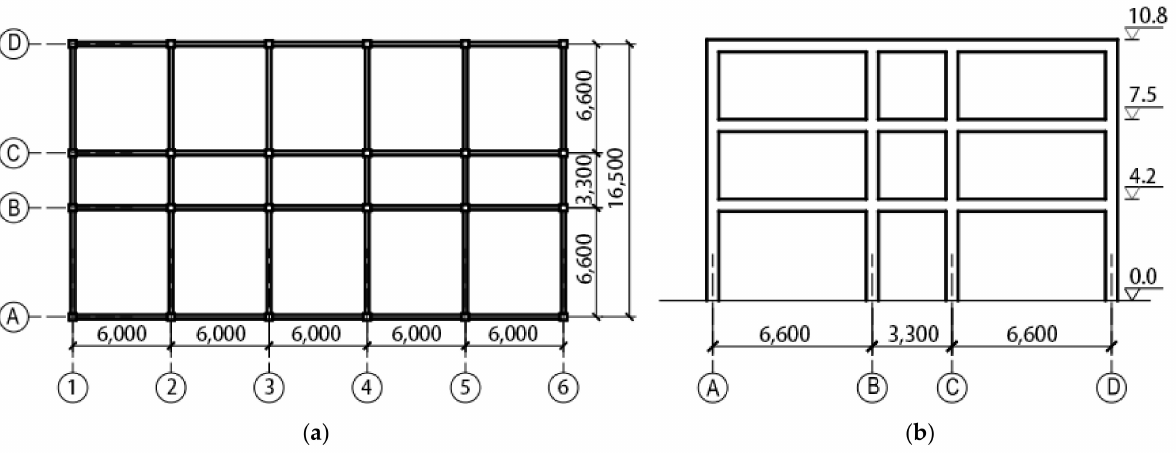
Figure 3. Layouts of the structure (3-story frame as an example): ( a ) plan layout (unit: mm); ( b ) elevation layout (unit of elevation: m; unit of bay: